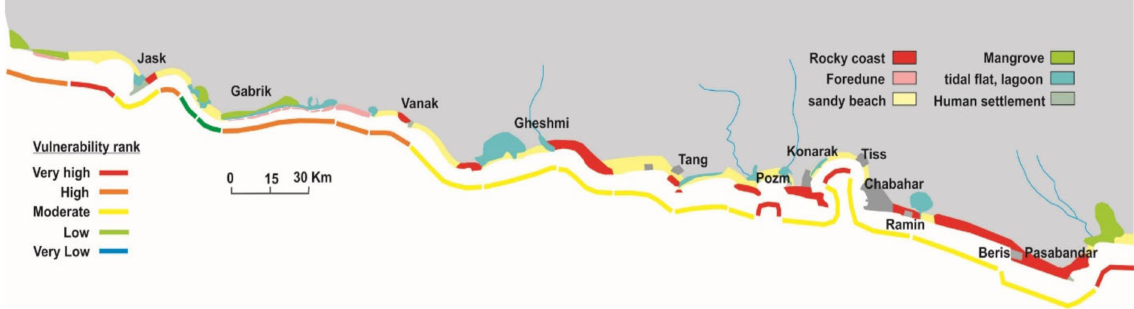
Figure 4. Risk rating of the Iranian coast of Makran based on the coastal